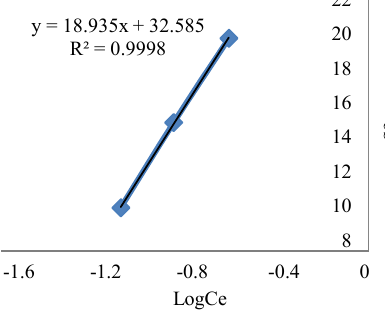
Fig. 8. Temkin isotherm